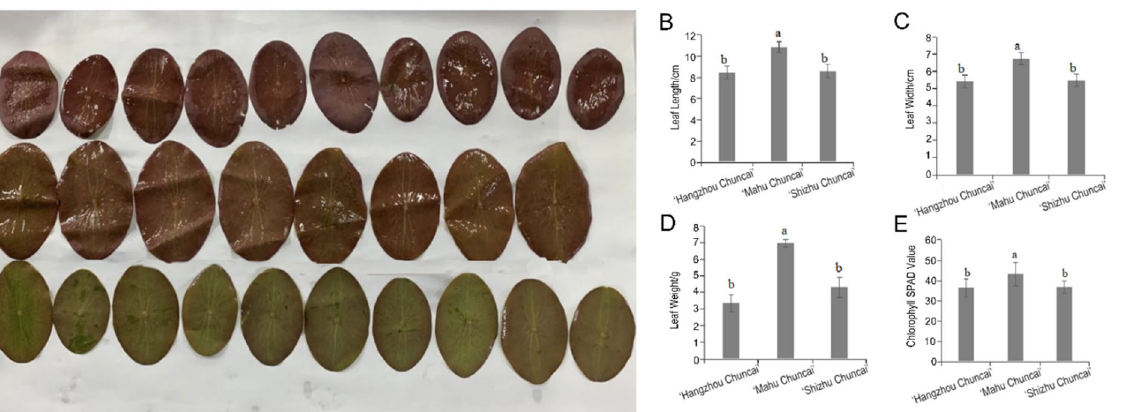
Figure 1. Comparison of morphology and nutrition in different varieties of B. schreberi . ( A ) Color and size of leaves of B. schreberi ; ( B – E ) Determination of the growth index of varieties of B. schreberi ; ( F – H ) Differences in contents of young bud of three varieties; different lowercase letters (a, b, c) indicate significant differences between different treatments at the 5% significant level. 30 leaves from each variety were randomly selected for each morphological index measurement. 3.2. Chloroplast Genome of ‘Mahu Chuncai’ A total of 7,712,942,700 bases were obtained by paired ‐ end sequencing, and 25,709,809 high ‐ quality clean reads (the average sequencing depth was 3734X) were ob ‐ tained after a strict filtering process (Table S1). Sequence assembly resulted in depths of coverage of 14.37X and covered 99.97% of the reference genome (KT705316.2). According to the Figure S1, the IGV screen capture showed that the chloroplast genome of ‘Mahu Chuncai’ didn’t have heteroplasmy and the structure is reliable and unique. After assem ‐ bly and editing, the cpDNA genome of ‘Mahu Chuncai’ was 158,973 bp in length with a highly conserved quadripartite structure. This genome included a large single copy se ‐ quence (LSC) of 88,779 bp, a small single copy sequence (SSC) of 19,512 bp, and a pair of inverted repeats (IRa and IRb) of 25,341 bp (Figure 2 and Table S2). Based on the annota ‐ tion analysis, the genome had 133 functional genes, comprising 88 protein ‐ coding genes, 37 tRNA genes, and eight rRNA genes. Analysis of gene structure indicated that 18 genes contained introns, among which 15 contained only one intron, whereas 3 genes ( rps12 , clpP , and ycf3 ) contained two introns. Moreover, nine protein ‐ coding and six tRNA genes had one intron, whereas no intron was found in the rRNA genes (Table 1). Notably, Trnk ‐ UUU located in the LSC region contained the largest intron (2510 bp in length).